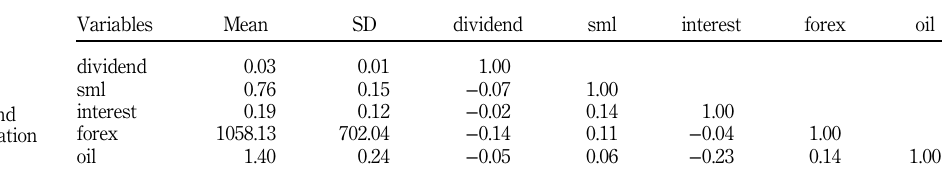
Table V. Mean values and pairwise correlation